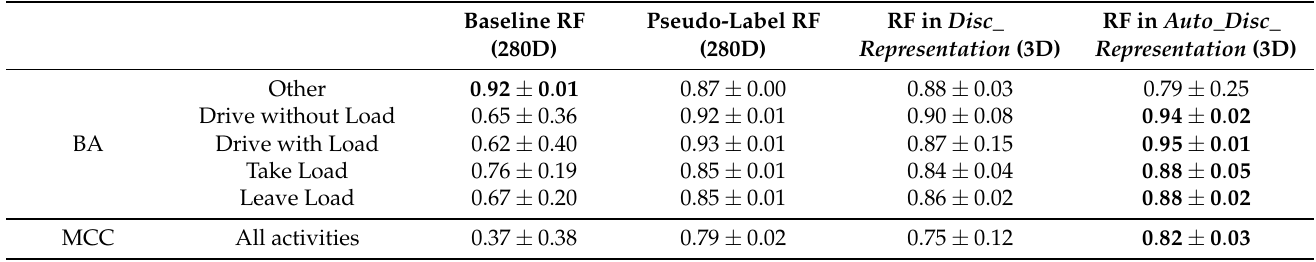
Table 3. Classification Results from different experiments after post-processing (mean ± 2 × std); boldface indicates the best performance (statistical significance) in each row.